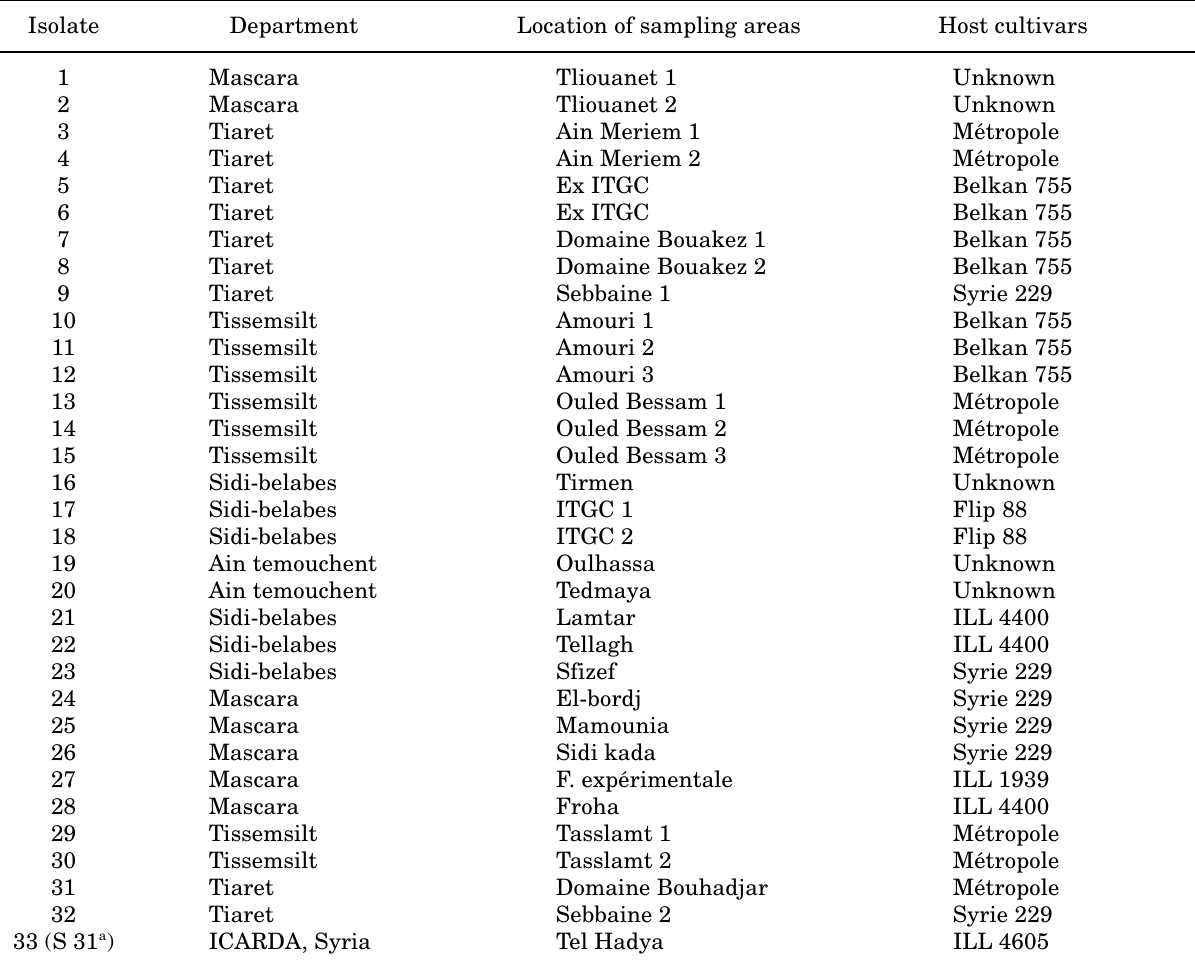
Table 1. Geographical origin of the Fusarium oxysporum f. sp. lentis isolates obtained from wilted lentil plant in north-western Algeria